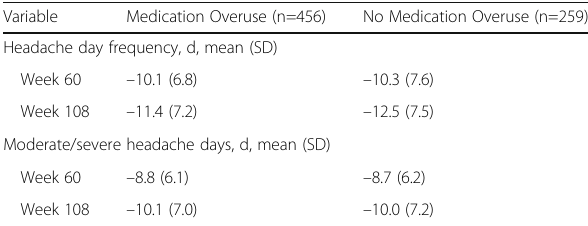
onabotulinumtoxinA-treated patients with and without a history of medication